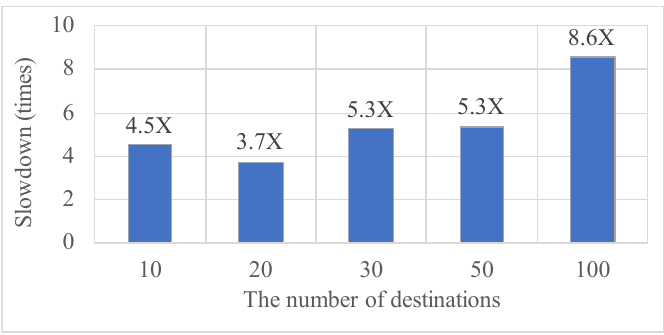
Figure 10. Slowdown of TSP heuristics vs. greedy